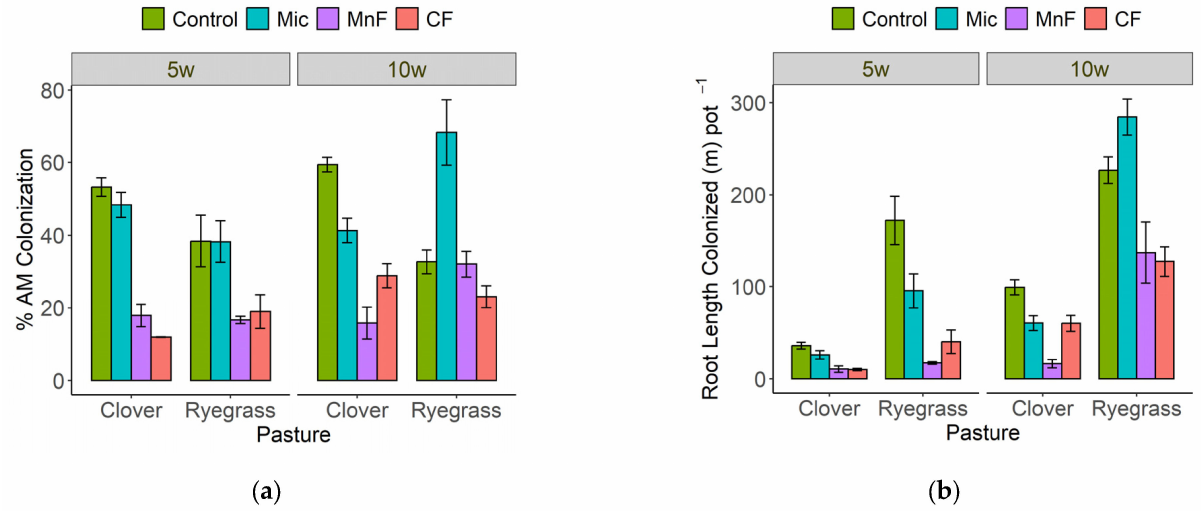
Figure 4. Mycorrhizal colonization as ( a ) % root length colonized and ( b ) length of root colonized (m pot − 1 ) for subterranean clover and annual ryegrass grown separately at 5 and 10 weeks. Treatments were untreated soil (Control), rock mineral fertilizer (MF), chemical fertilizer (CF) and microbial inoculant (Mic). Results are presented as means + standard